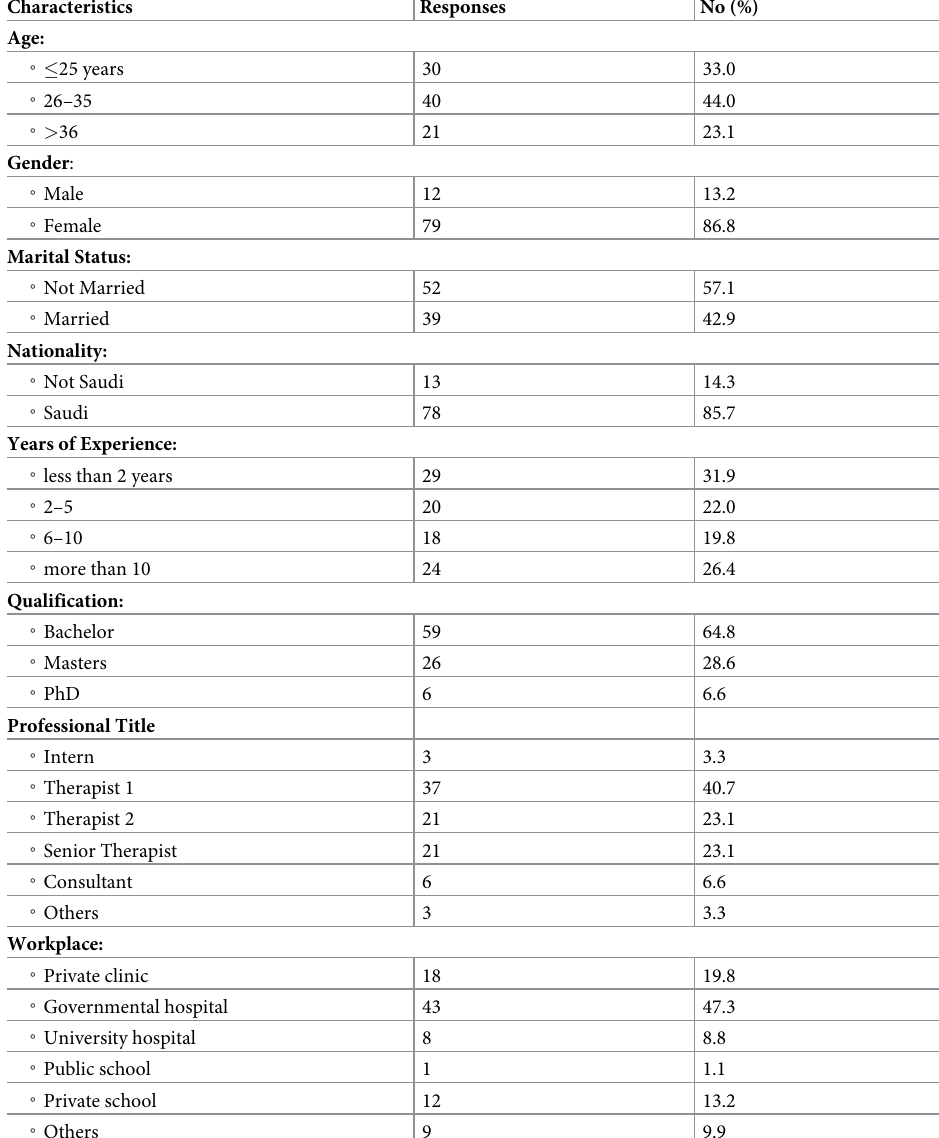
Table 1. Personal and professional practice-related characteristics of respondent SLPs (n = 91).